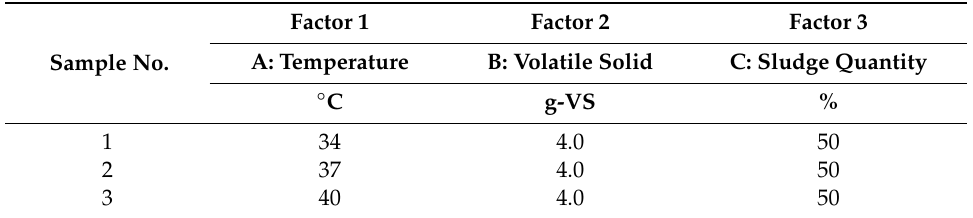
Table 1. Variable matrix and levels in actual values.